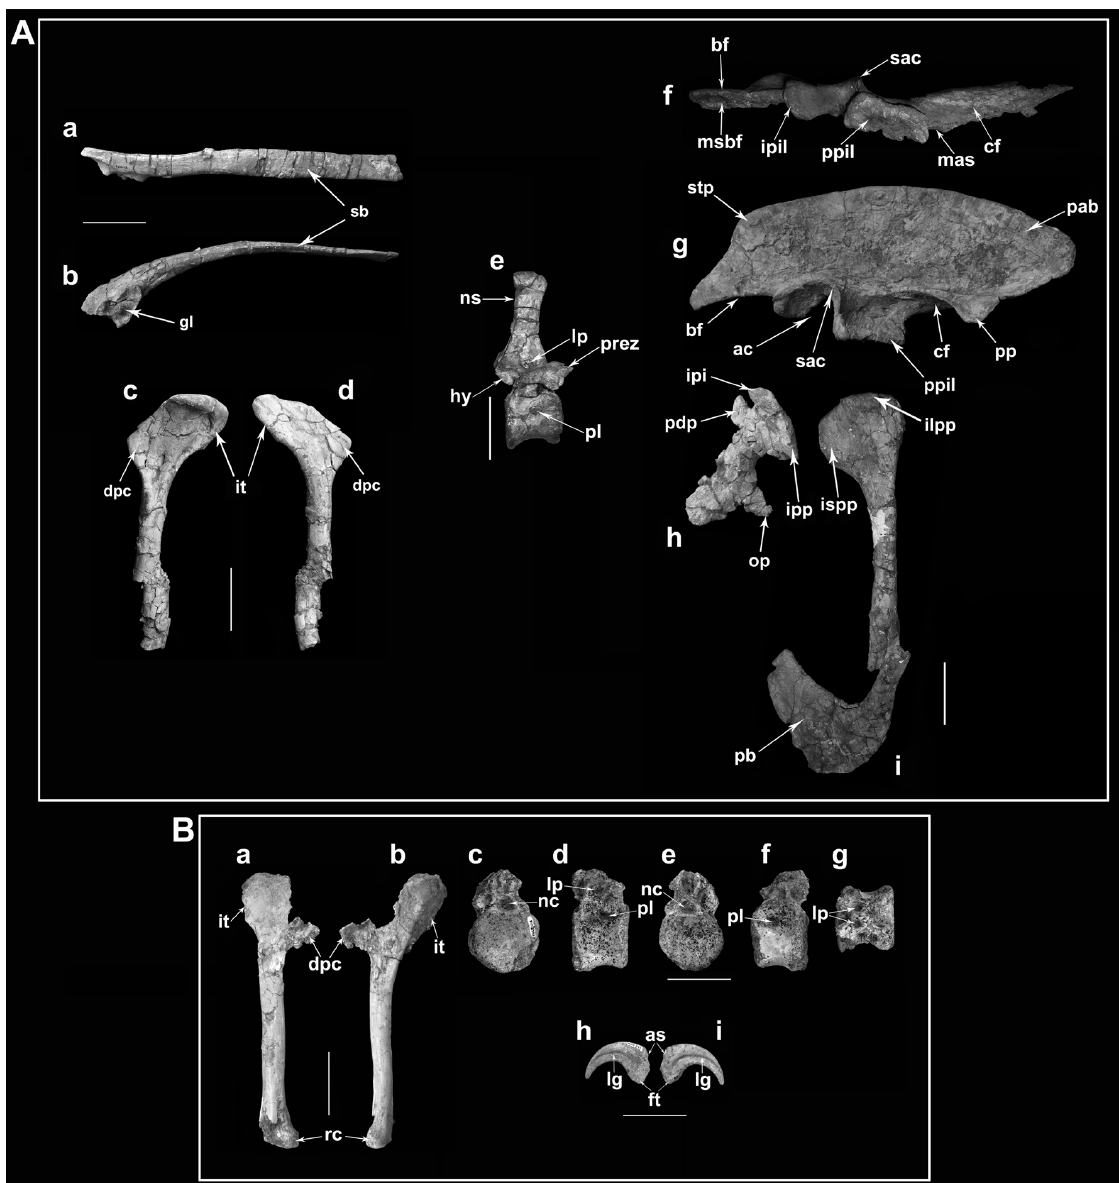
Fig. 3 – A : holotype of Unenlagia comahuensis (MCF PVPH 78); a and b: left scapula, in dorsal and lateral views; c and d: left humerus, in lateral and medial views; e: dorsal vertebra 13th?, in right lateral view; f-i: pelvic girdle; f and g: left ilium, in ventral and lateral views; h; left ischium, in lateral view; i: left pubis, in lateral view. Scale bars: 5 cm. B : Unenlagia paynemili ; a-b: holotype (MUCPv-349); a and b: left humerus, in medial and lateral views; c-i: referred materials; c-g (MUCPv-416): dorsal vertebra, in anterior (c), right lateral (d), posterior (e), left lateral (f), and dorsal (g) views; h and i (MUCPv-343): manual ungueal, in lateral views. The remaining materials of the holotype and referred materials (MUCPv-409) are showed in Figure 4. Scale bars: 5 cm. Abbreviations : the same of Figure 2, except: as, articular surface; cf, fossa for M. cuppedicus ; ft, flexor tubercle; hy, hyposphene; ilpp, iliac process of the pubis; ipi, iliac process of the ischium; ipil, ischiadic process of the ilium; ispp, ischiadic process of the pubis; lg, lateral groove; lp, lateral pit; mas, medial antiliac shelf; msbf, medial shelf of the brevis fossa; nc, neural canal; pab, preacetabular blade; pb, pubic boot; pl, pleurocoel; pp, pendant process; ppil, pubic process of the ilium; rc, radial condyle; sac, supracetabular crest; sb, scapular blade; stp, supratrochanteric